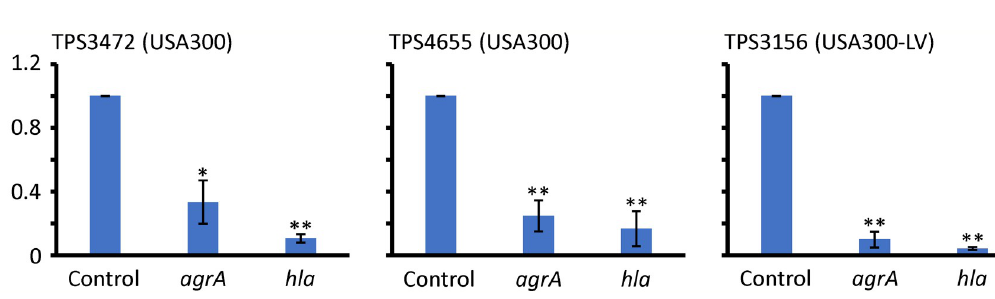
PLOS ONE | https://doi.org/10.1371/journal.pone.0214470 March 28,